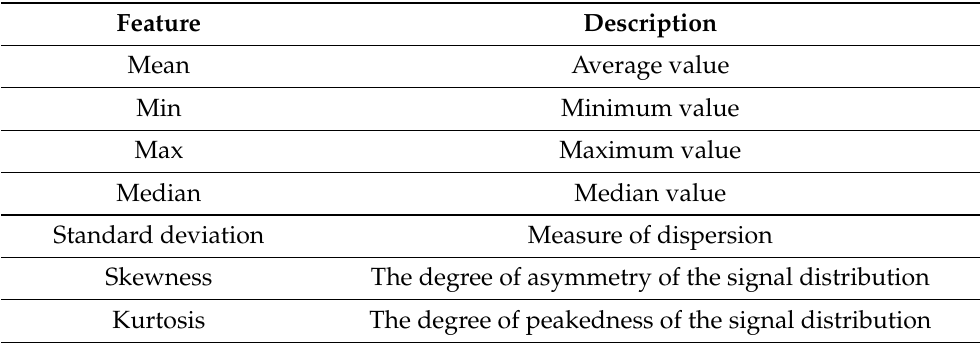
Table 5. Description of selected features.